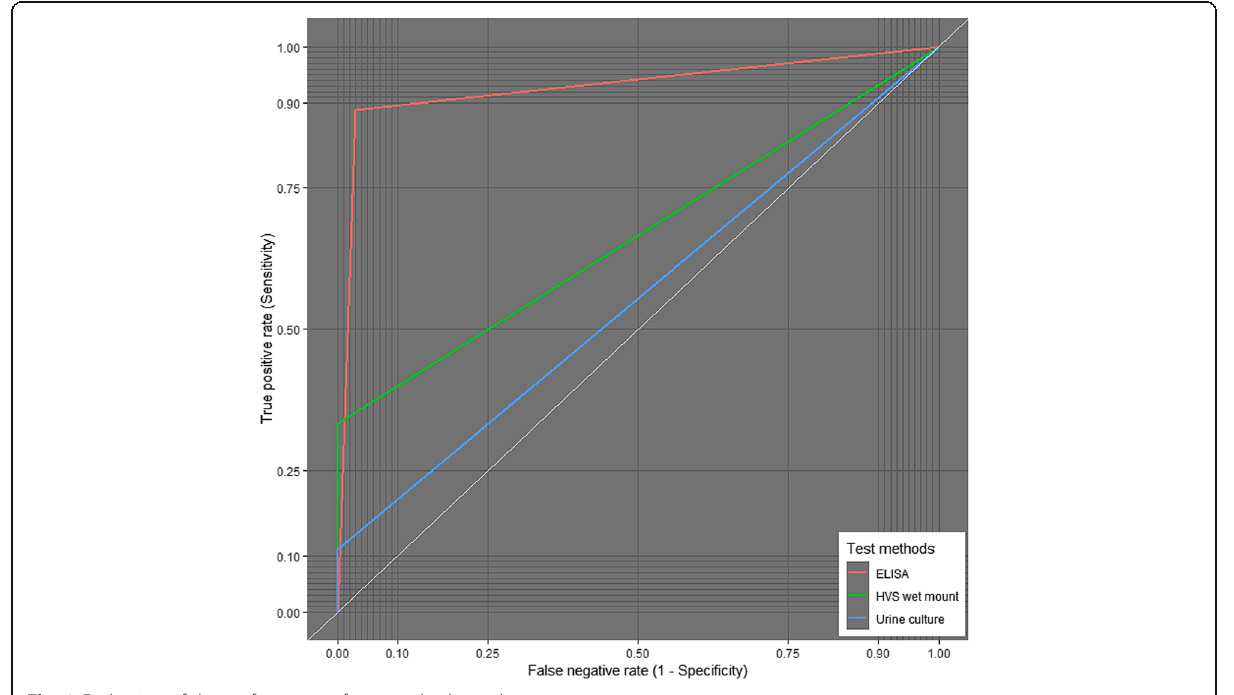
Fig. 2 Evaluation of the performance of test methods used